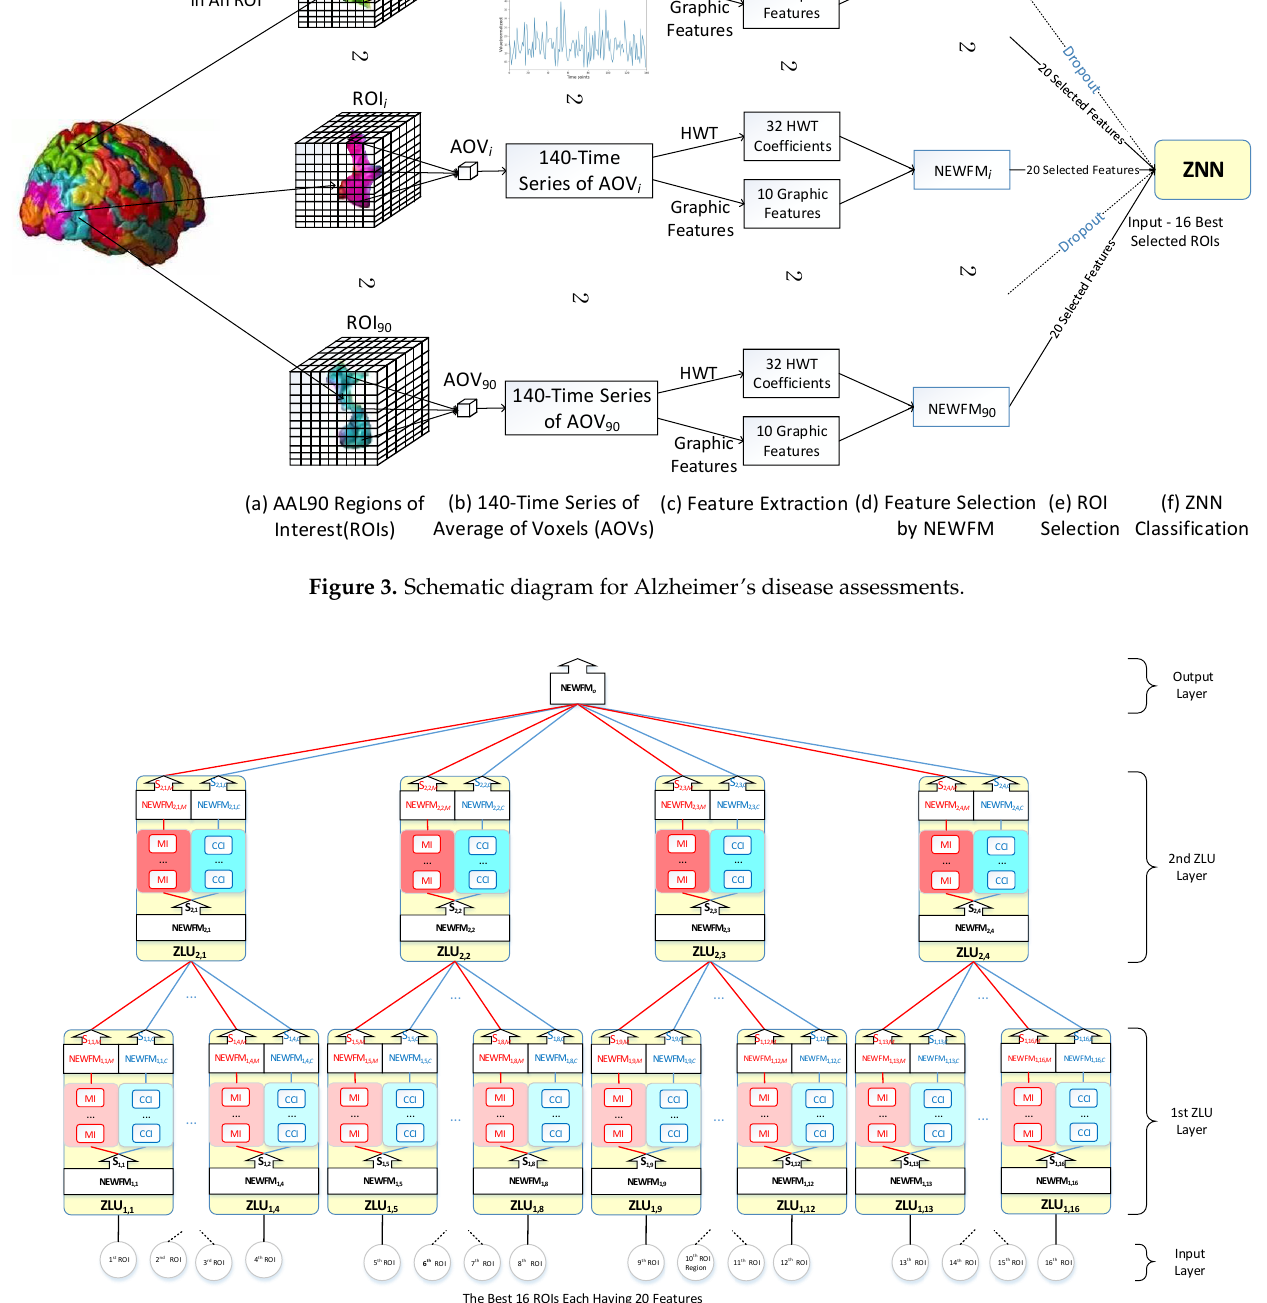
Figure 4. ZNN m odel for Alzheimer’s disease classification. Figure 4. ZNN model for Alzheimer’s disease